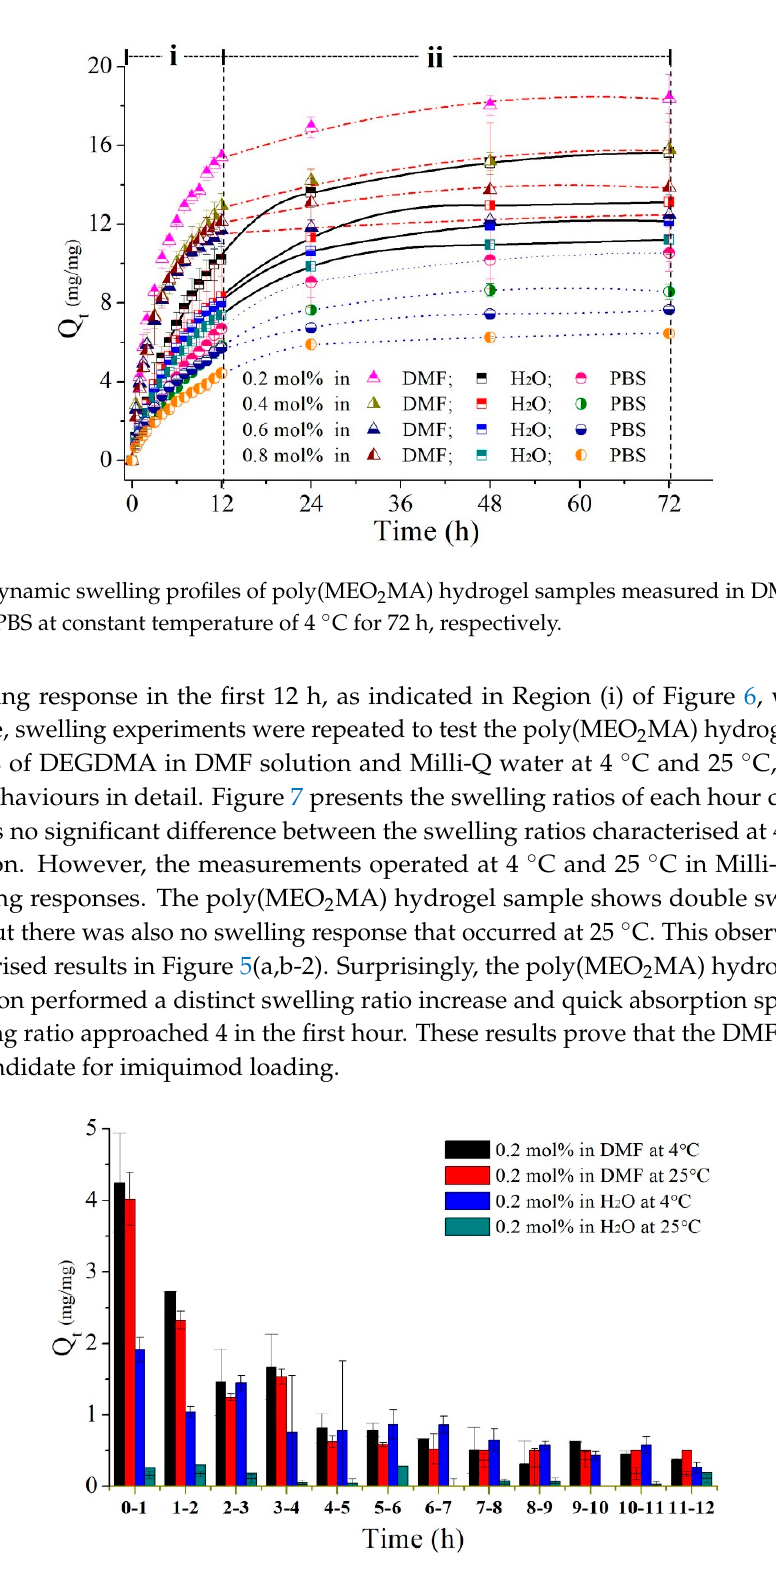
Figure 7. The swelling ratios of poly(MEO 2 MA) hydrogel, crosslinked with 0.2 mol % of DEGDMA samples, within 12 h in Milli-Q water and DMF solution.